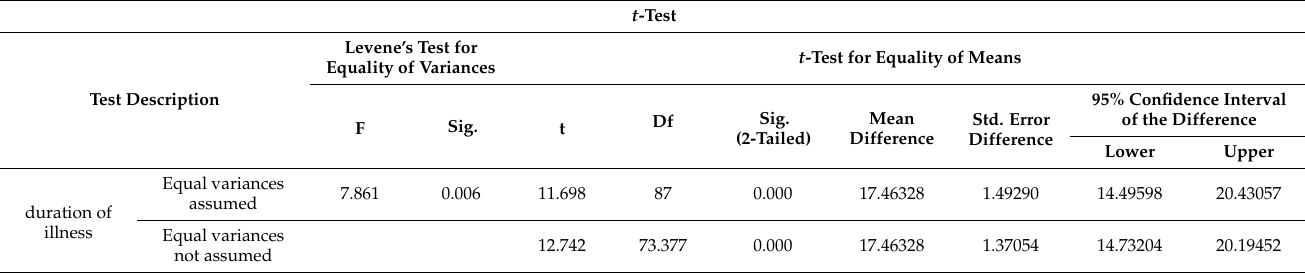
Table 4. Comparison of duration of illness and usage of steroid in both groups. t